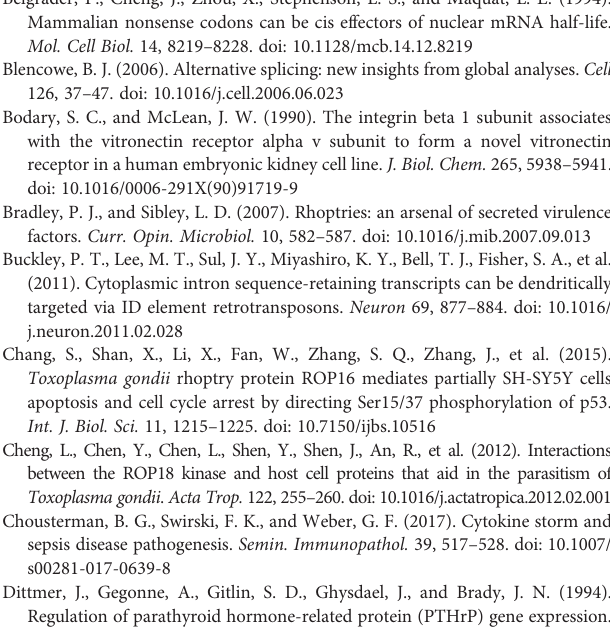
ROP18. PL, PageRuler ™ Prestained Protein Ladder; C, Extract of control HEK293 transfected with the plasmid PCMV-N-HA; 18, Extract of HEK293 transfected with the plasmid